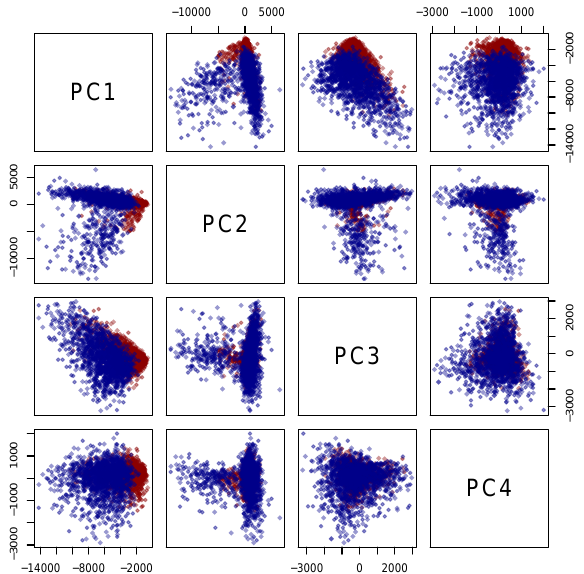
Figure 6. Projections on the coordinate planes of the distribution of the first four principal compo- nents on the coordinate planes. The healthy and the tumoral samples are labeled by blue and red points,